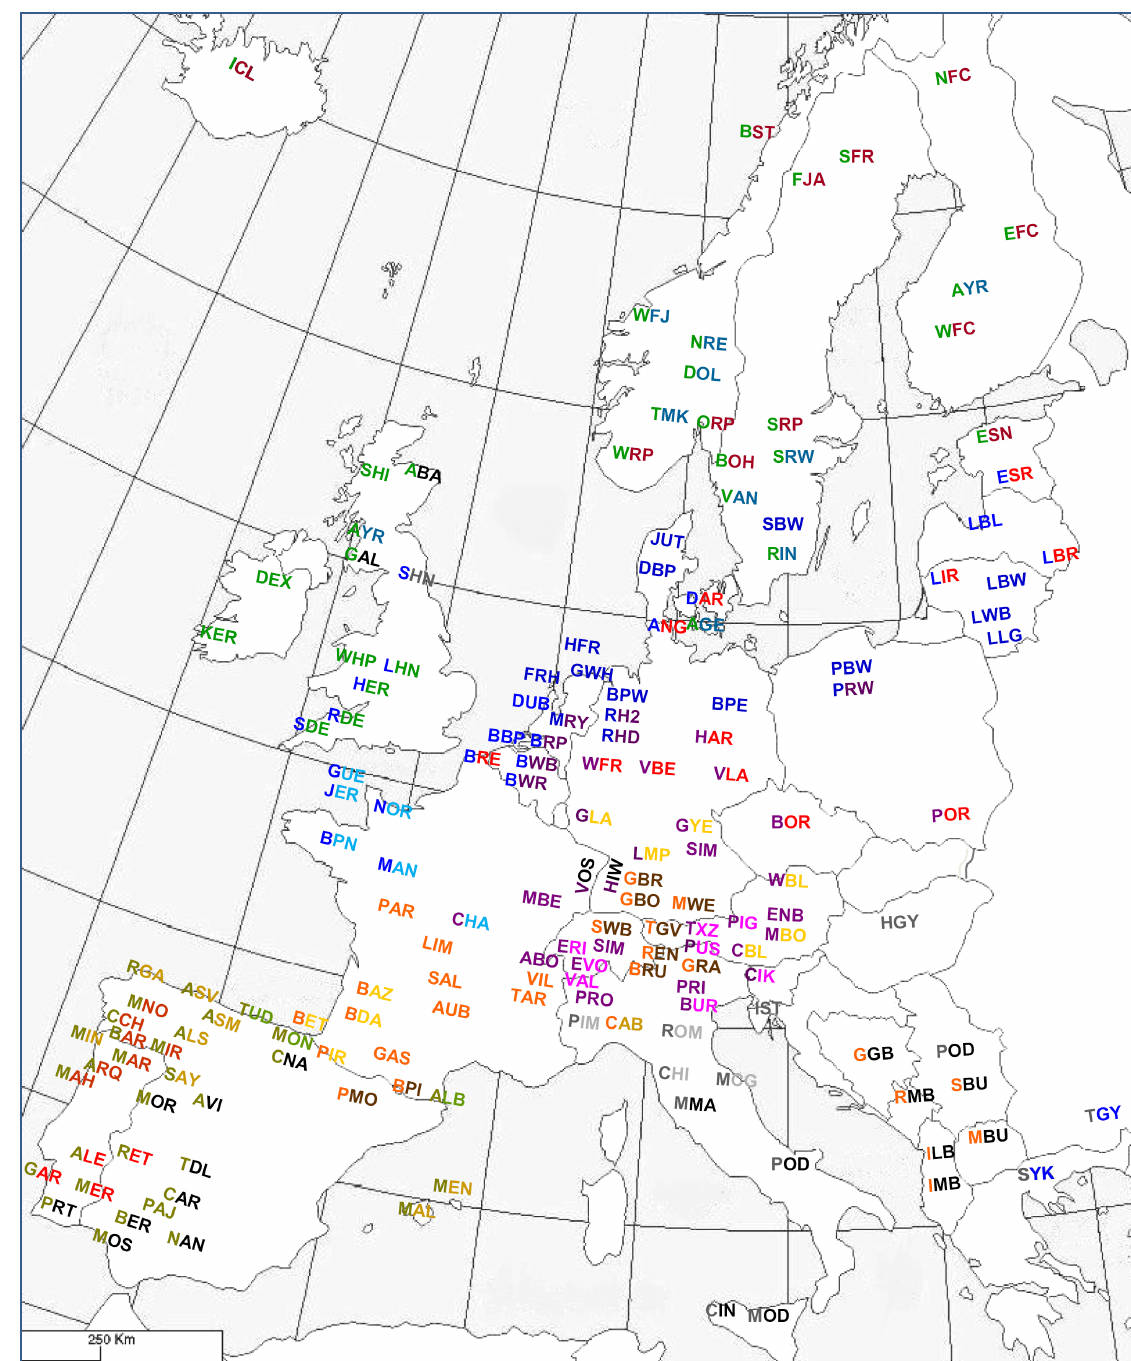
Figure 8. Classification of European breeds of Felius [2] (Table S33). Only breeds are shown that also have been classified by genetic analysis (Figure 9). In the three-letter code, the color of the first letter indicates the group according to the color key and the second and third letter the